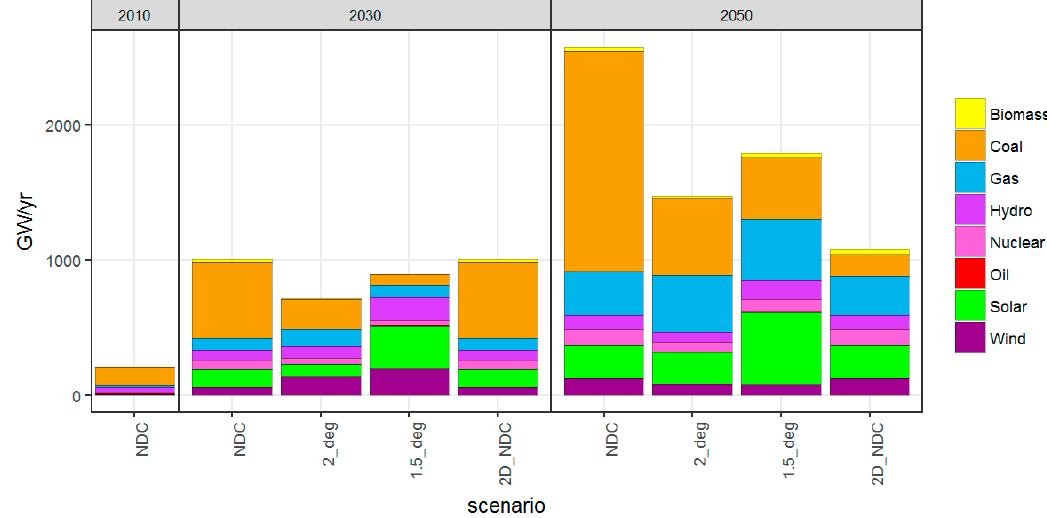
Figure 5. Total electricity generation and share of non-fossil fuel (%) in different scenarios in 2050.